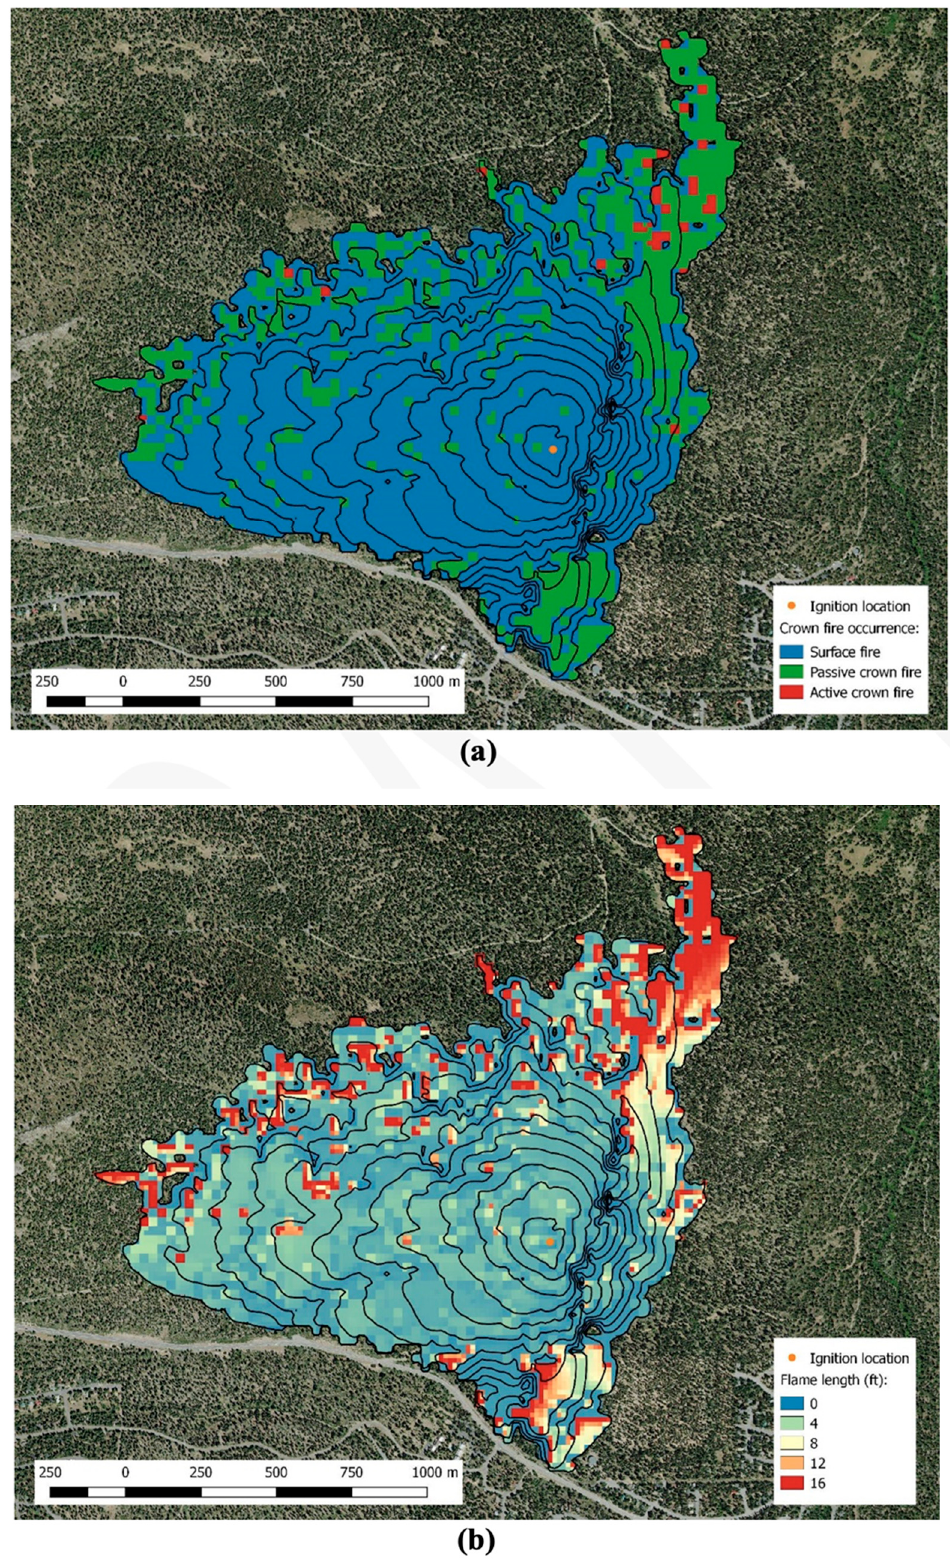
Figure 9. Example ELMFIRE fire spread simulation for individual fire ignition. ( a ) Fire type (surface fire, passive crown fire, or active crown fire). ( b ) Flame length in feet.